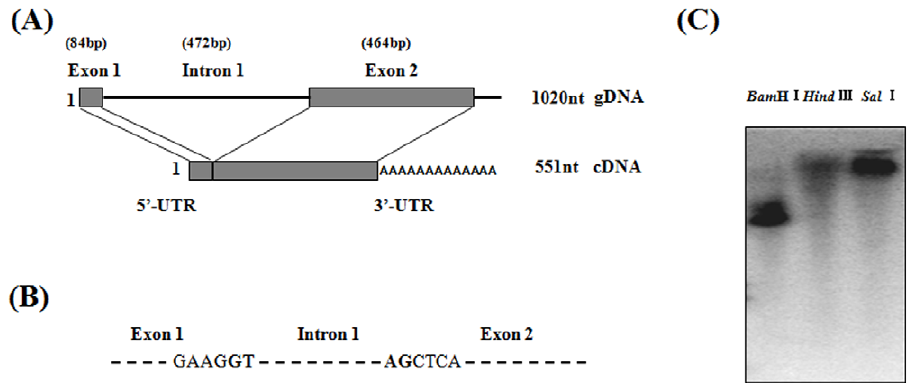
Figure 6. Structure of the Slmg7 gene. Schematic structure (A), the boundary nucleotides between the exons and introns (B) and Southern blot analysis for copy number (C) of the S. litura Slmg7 gene. (A) The top panel is for the gene structure and the bottom panel is for the cDNA sequence. The intron sequence is indicated with lines and the exons are indicated with boxes. (B) The intron/exon junction nucleotides are bolded. (C) Ten micrograms of genomic DNA was digested with the restriction enzymes Bam H I, Hind III and Sal I and separated on 1% agarose gel. A 32 P-labeled Slmg7 cDNA was used as a probe.